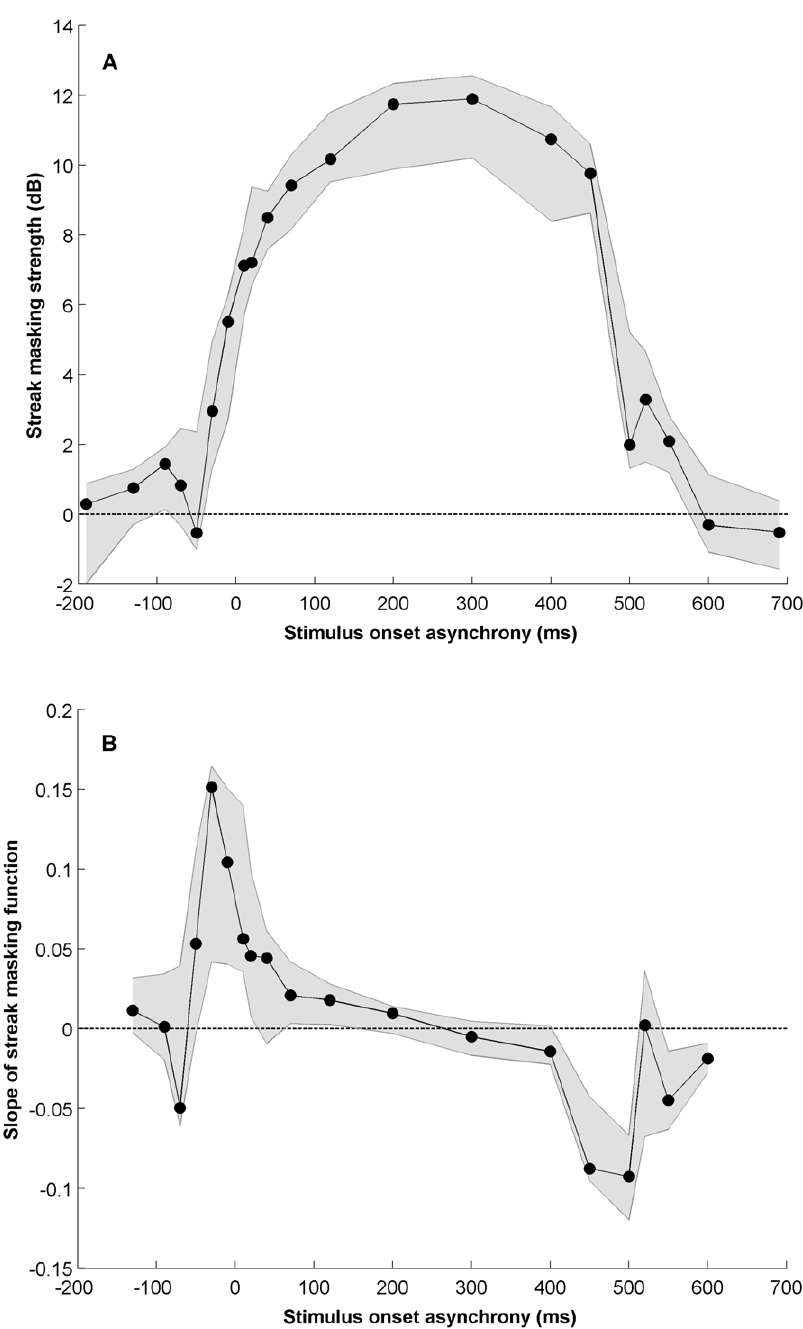
Figure 4. Masking specific to motion streaks – differences and first derivative. a) The masking component specific to motion streaks plotted as a function of the grating target’s asynchrony relative to motion onset. The plot shows group means (n=7), flanked by 90% confidence intervals, of the difference between the fast parallel and fast orthogonal conditions. This contrast reveals the streak-specific masking component because while both conditions contain fast translating dots (and therefore motion streaks), masking occurs only in the parallel condition where target and mask are iso-oriented. b) The first derivative of the streak-specific masking component, calculated using the three-point method, plotted in panel A, flanked by 90% confidence intervals. The sustained increase in masking in panel A around 0 ms is indicated by the four consecutive positive slopes around 0 ms. The points either side of this series of four points are not significantly different from zero. Linearly interpolating between the lower confidence intervals, this elevated series of points is significant between { 48 and z 29 ms, indicating a temporal integration period of 77